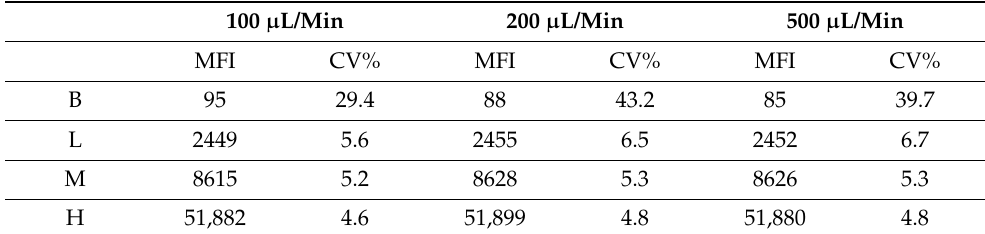
Table 2. Laser with a flat-top beam profile.